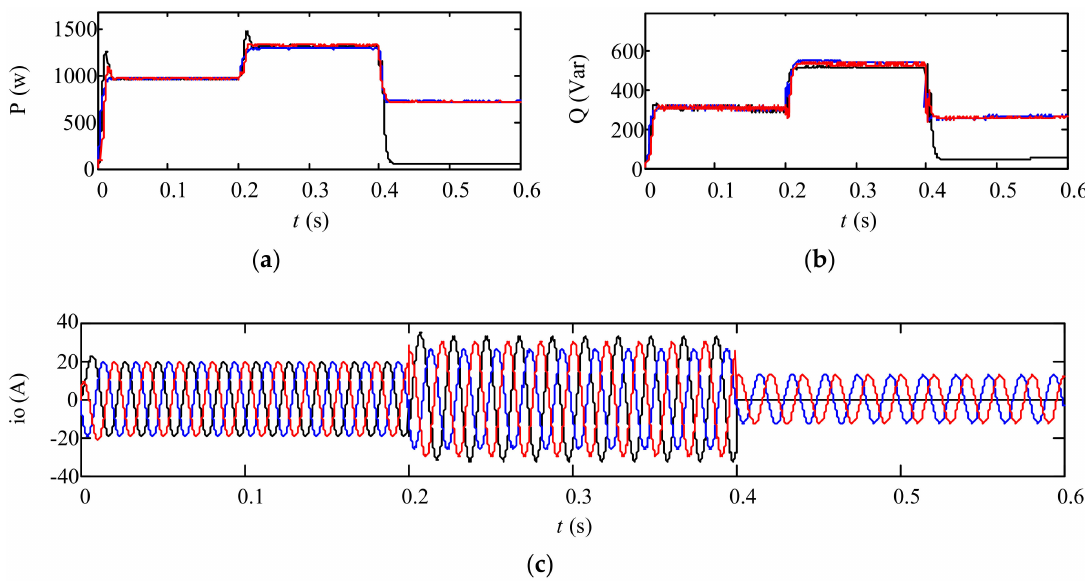
Figure 10. Simulation waveforms under various load conditions. ( a ) Three-phase load active powers; ( b ) Three-phase load reactive powers; ( c ) load currents.